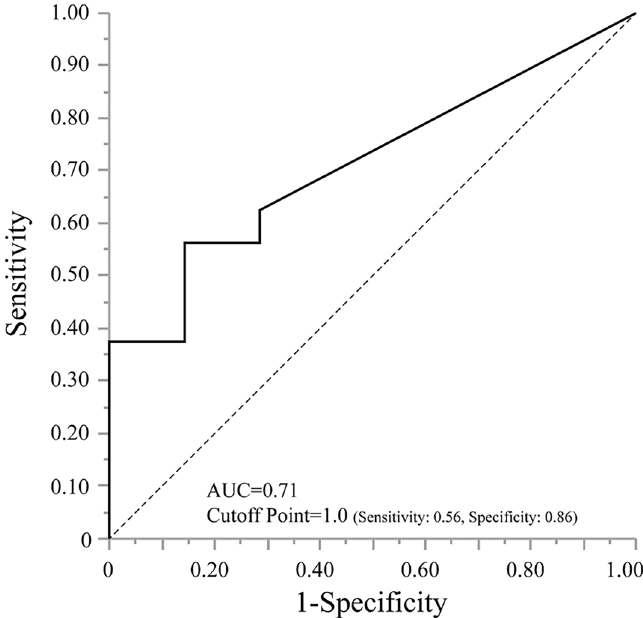
Figure 2. The ROC curve for CT90. The ROC curve analysis showed that the best cutoff value for CT90 for predicting increase or unchanged in negative affectivity after sleep was 1.0% (sensitivity, 56.3%; specificity, 85.7%), the corresponding AUC was 0.714. AUC, corresponding an area under the curve; CT90, percentage of cumulative time of blood oxygen saturation below 90% during sleep; ROC, receiver operating